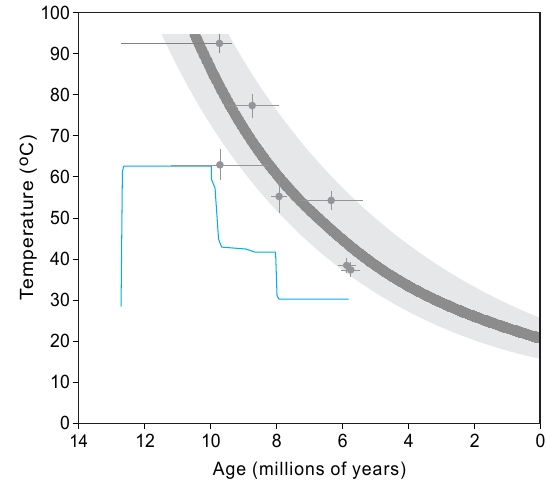
Figure A3. Sensitivity simulation illustrating the role of water con- vection. The graph shows the temperature at reference point ( z = 300m). Porosity changes with time as in simulation of Whelan et al. (2008). There was no magma